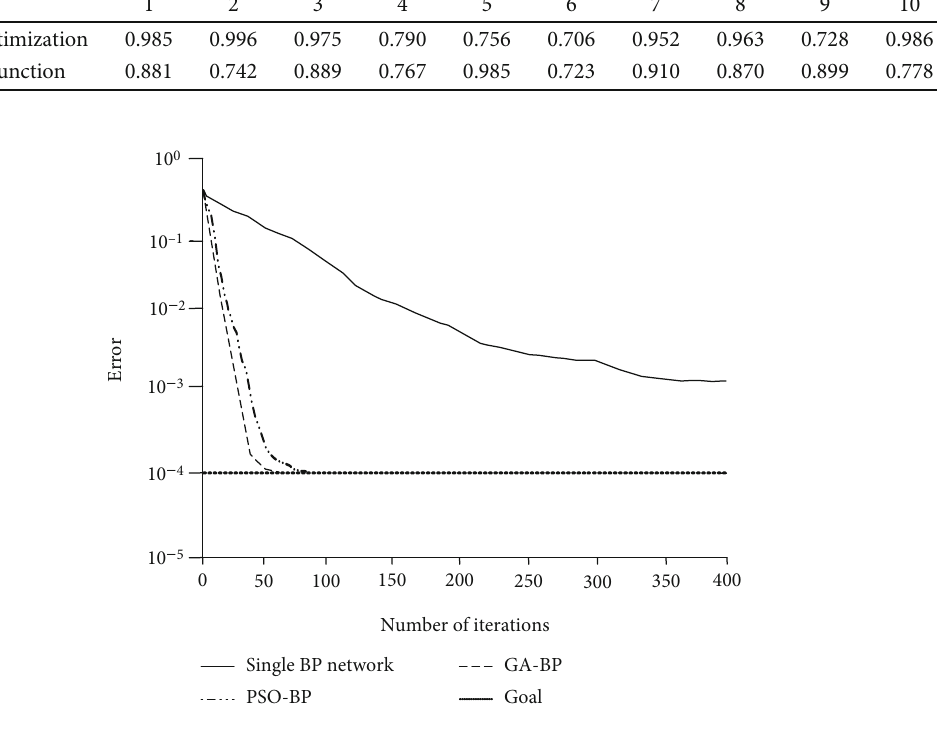
Figure 4: Comparison diagram of iteration times of algorithm